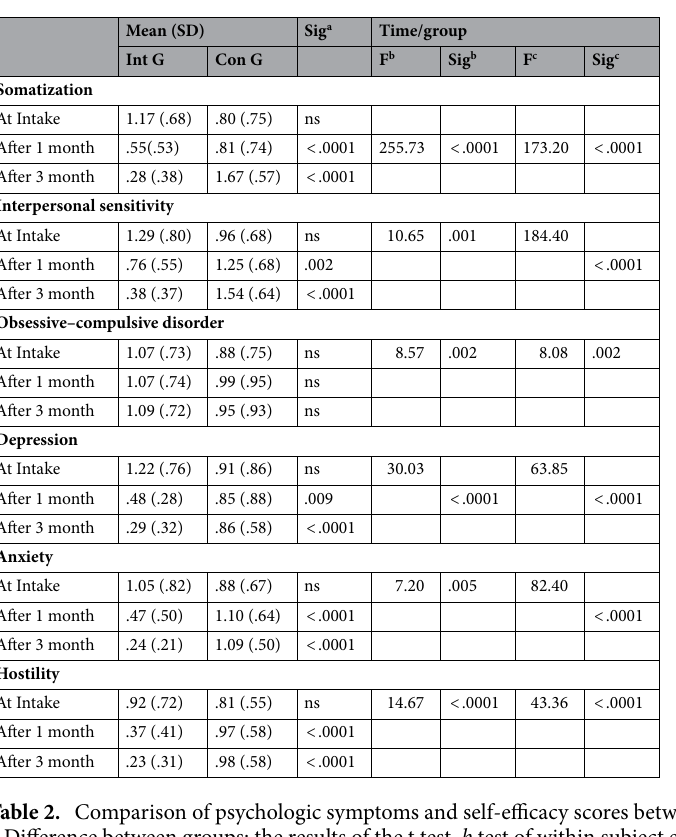
Table 2. Comparison of psychologic symptoms and self-efficacy scores between two groups by three times. a Difference between groups; the results of the t test. b test of within subject effect. c test of between subject effect. SD standard deviation; sig significance; ns not significant.